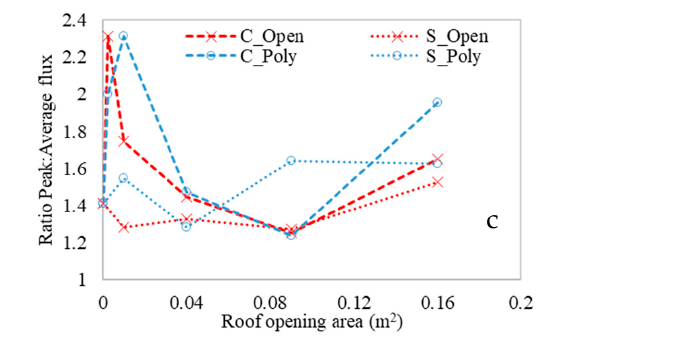
Table 3. Example materials from informal settlements that show a high degree of flux-sensitivity [38].